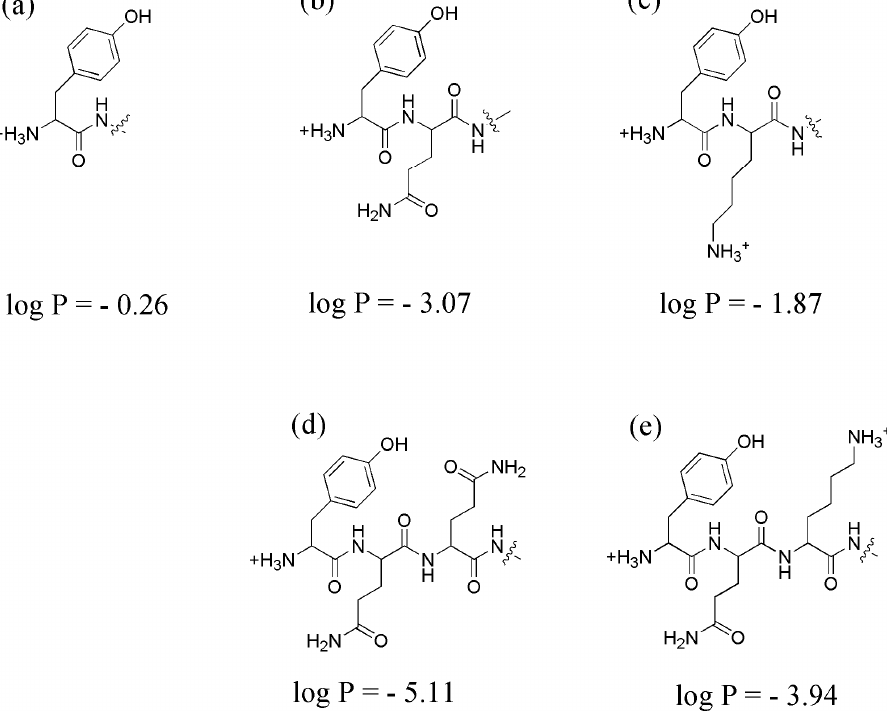
Figure 9. Structures of N-termini containing ( a ) Tyr; ( b ) Tyr-Gln; ( c ) Tyr-Lys; ( d ) Tyr-Gln-Gln; ( e ) Tyr- Gln-Lys and their log P calculated using ChemDraw Ultra.